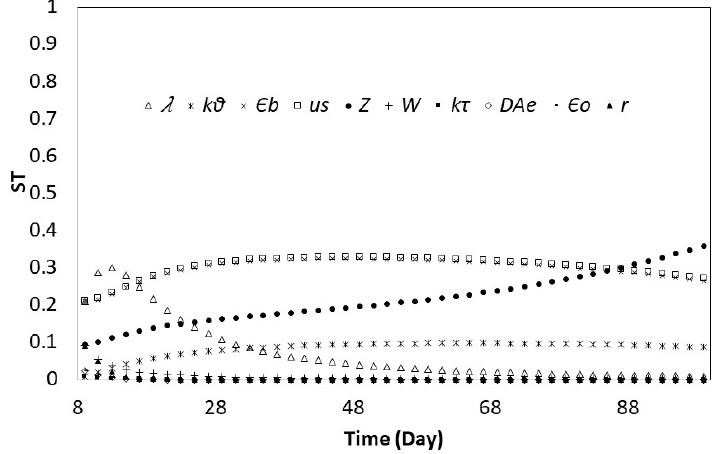
Figure 7. GSA of the model at radius 1.5 cm.